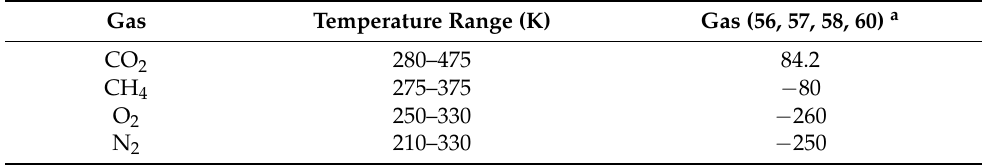
Table 2. Gas–gas group interaction-energy parameters u nm and temperature